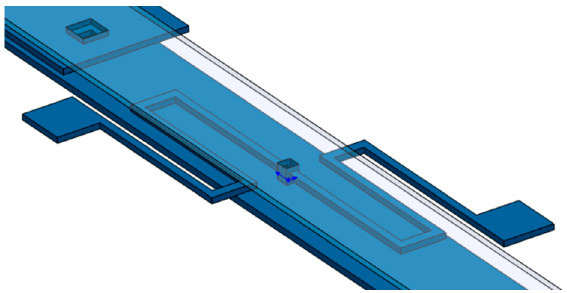
Figure 2. 3D view of the serpentine springs that support the mobile arm of the microgripper.